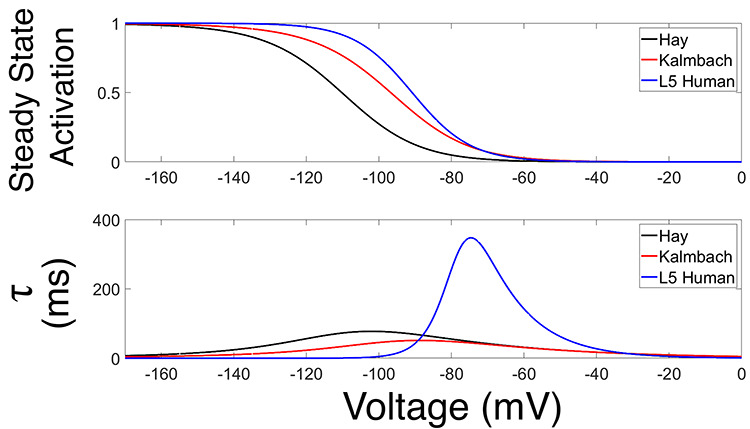
Comparison of h-current models used in three cortical pyramidal neuron models. Plot of steady-state activation curve (top) and \documentclass[12pt]{minimal}
\usepackage{amsmath}
\usepackage{wasysym}
\usepackage{amsfonts}
\usepackage{amssymb}
\usepackage{amsbsy}
\usepackage{upgreek}
\usepackage{mathrsfs}
\setlength{\oddsidemargin}{-69pt}
\begin{document}
}{}$\tau $\end{document} (bottom) of the h-current models used by Hay et al. (2011), Kalmbach et al. (2018), and in the model presented in this paper (referred to as “L5 Human”).